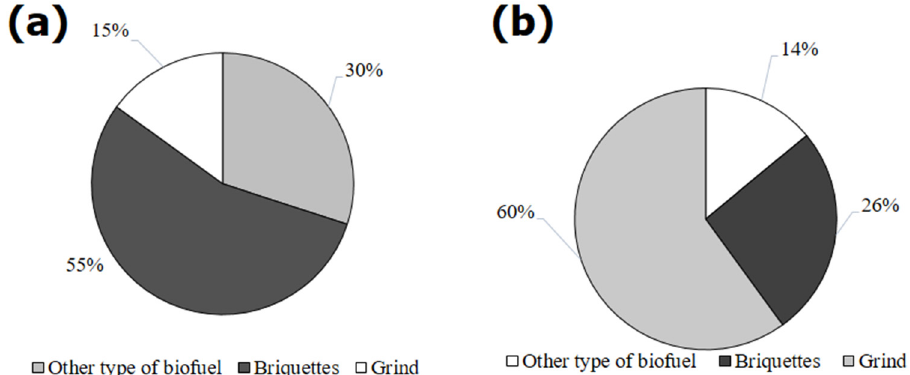
Figure 6. Potential percentage of material available for briquette production: ( a ) sawdust; ( b ) shavings.